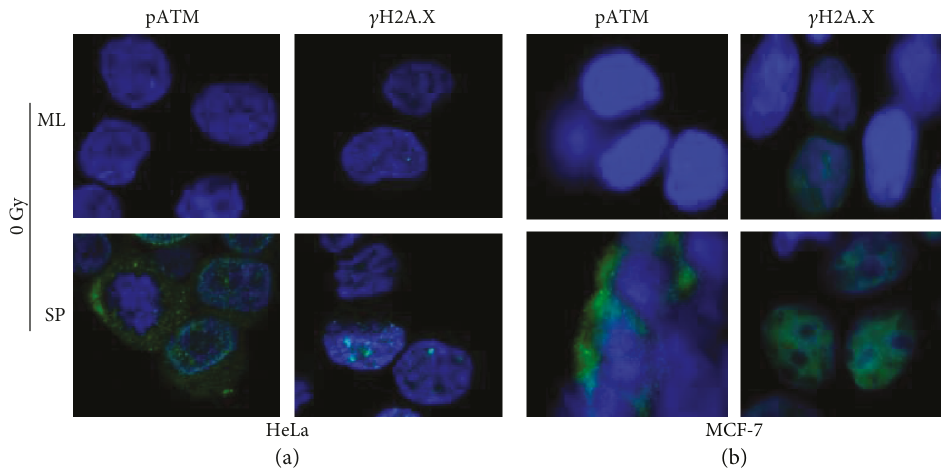
Figure 4: Cancer stem cells have baseline expression of pATM and γ H2A.X. Immuno fl uorescence staining for pATM and γ H2A.X protein (green). Visualization of nuclei by DAPI (blue). (a) HeLa SP cultures expressed pATM and γ H2A.X in baseline levels. (b) MCF-7 SP cultures expressed pATM and γ H2A.X in baseline levels. The representative images of the microscopy analysis indicate that pATM and γ H2A.X proteins are expressed in baseline levels in CSC cultures. Objective 60x.